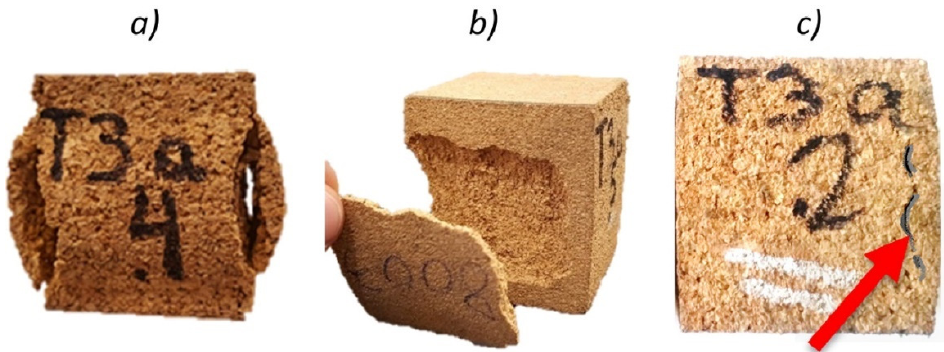
Figure 6. Decohesion of cork plugs after performing a dynamic compression at 100 °C on 168 kg/m 3 ( a ), 199 kg/m 3 ( b ) and 216 kg/m 3 ( c ) agglomerated corks (Reprinted with permission from [57]).